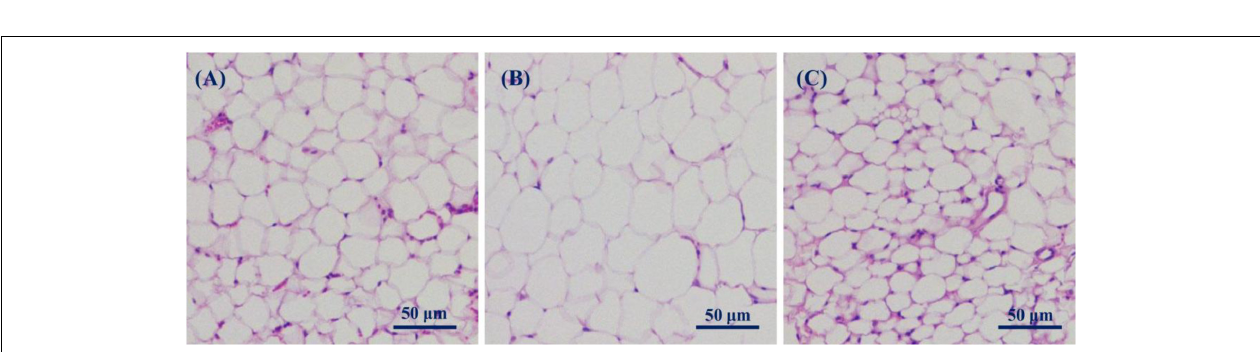
FIGURE 4 | The effect of bamboo shoot powder on the biochemical parameters of TG (A) , GLU (B) , CHOL (C) , HDL-C (D) , and LDL-C (E) of mice fed a HFD for 7 weeks. Data are means ± SEM, n = 10/group. * p < 0.05, *** p < 0.001, vs. LFC group. # p < 0.05, ## p < 0.01, ### p < 0.001, vs. HFD group.